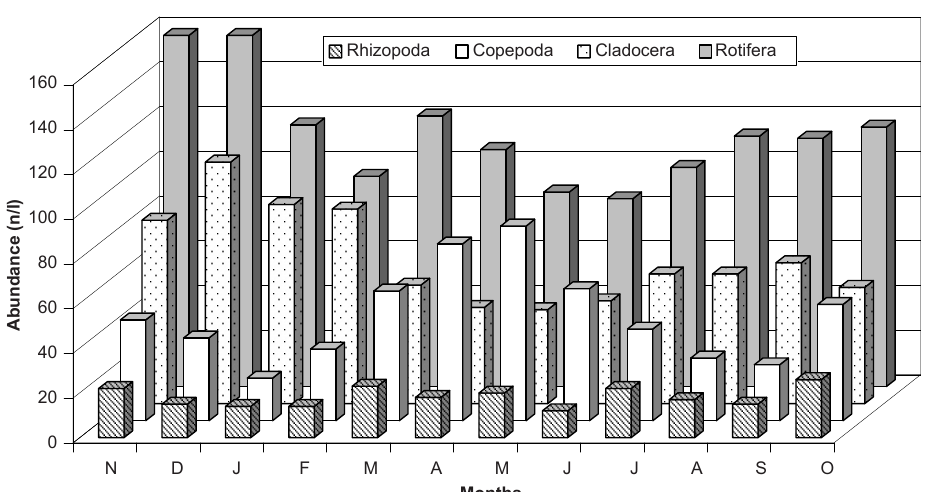
Figure 6. Monthly variations in abundance of different groups of zooplankton (2002–03)